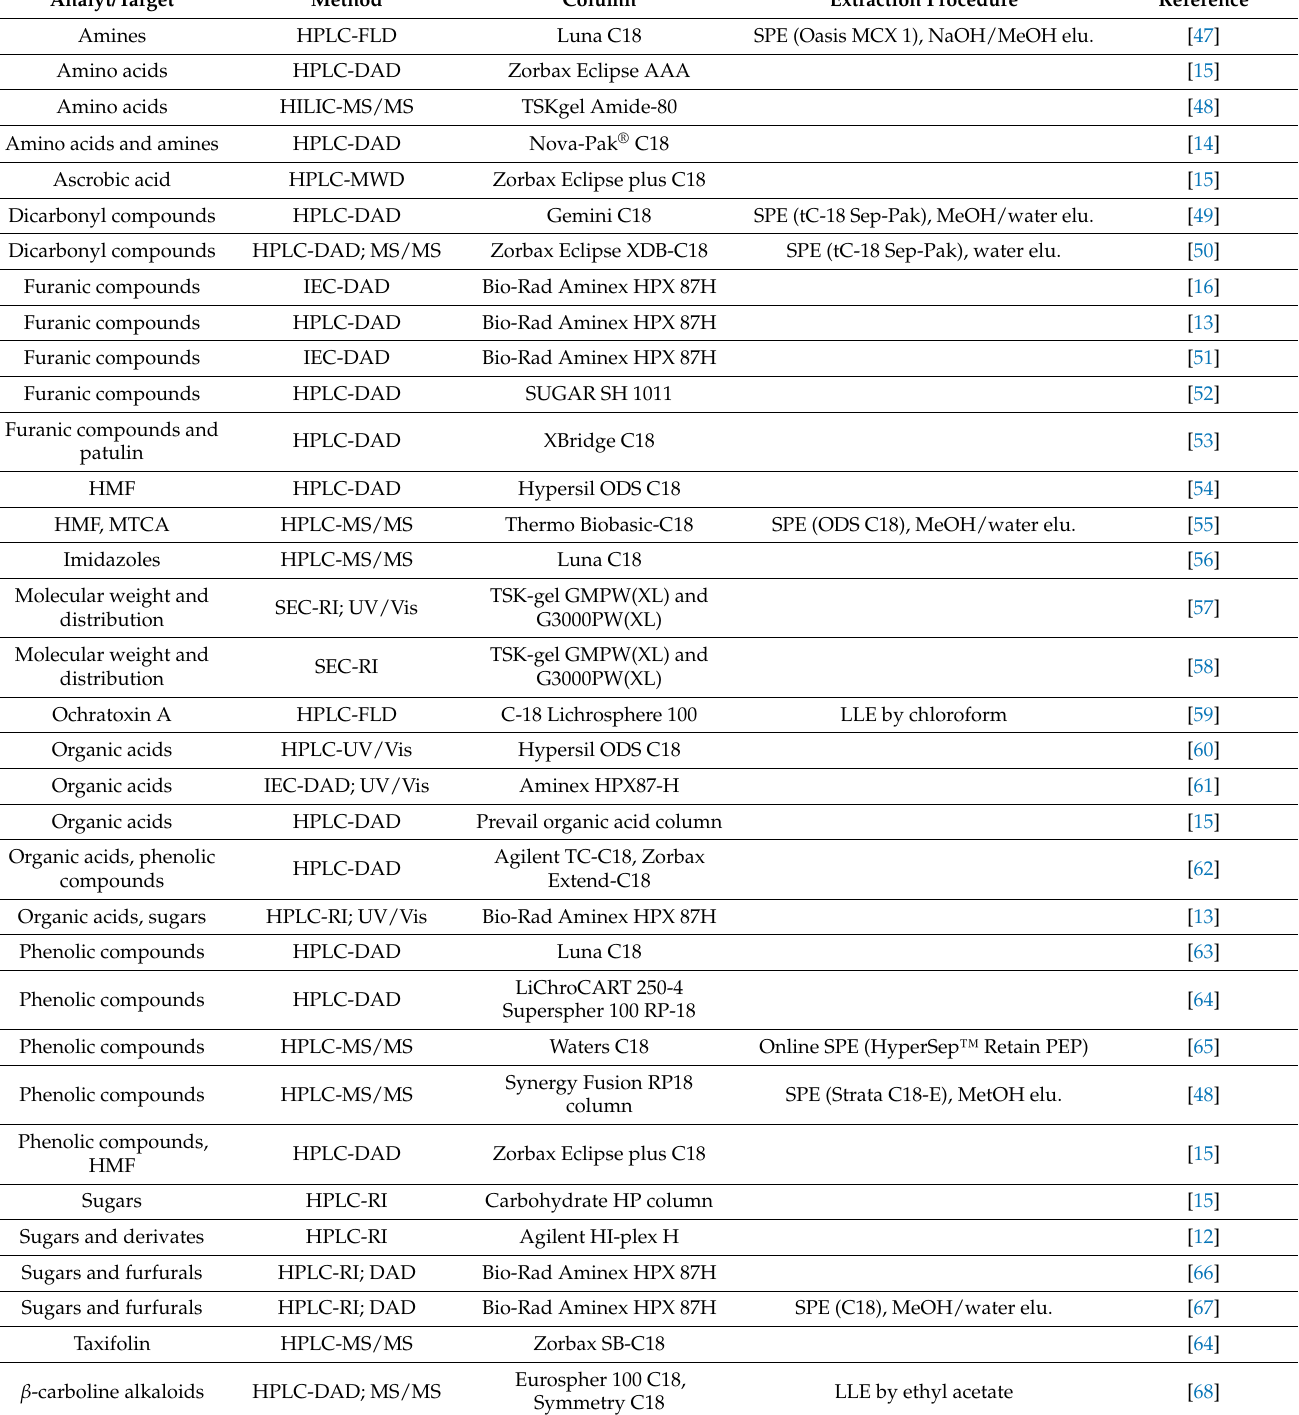
Table 2. Table of methods used for HPLC analysis of balsamic vinegar